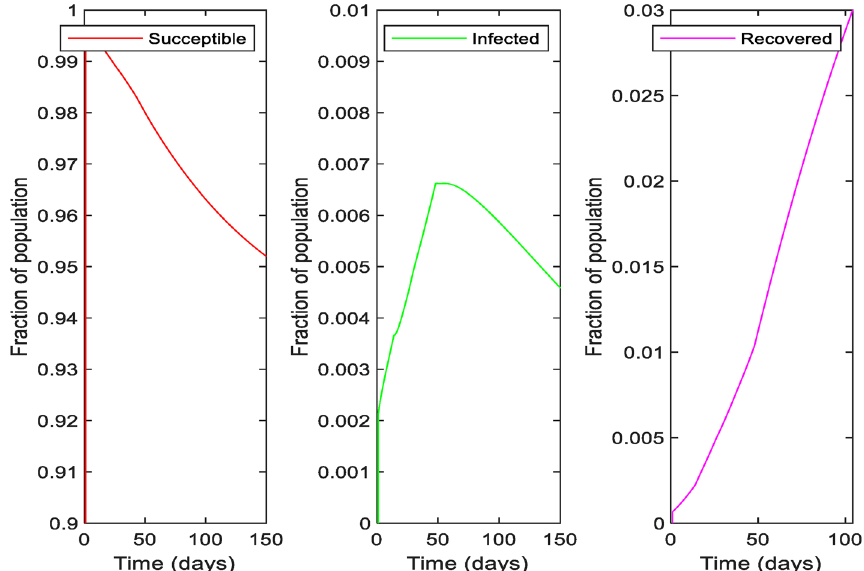
Figure 7. The prediction of susceptible, recovered cases and cases of